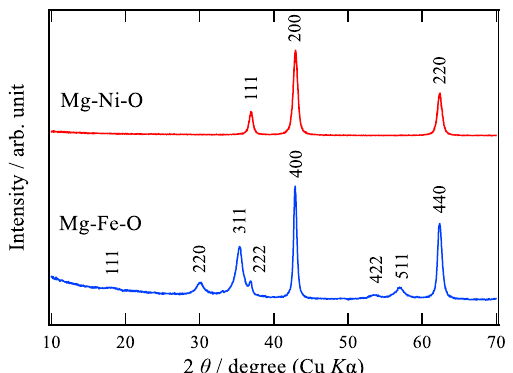
Figure 1. X-ray diffraction patterns of Mg–Fe–O and Mg–Ni–O after the thermal decomposition.